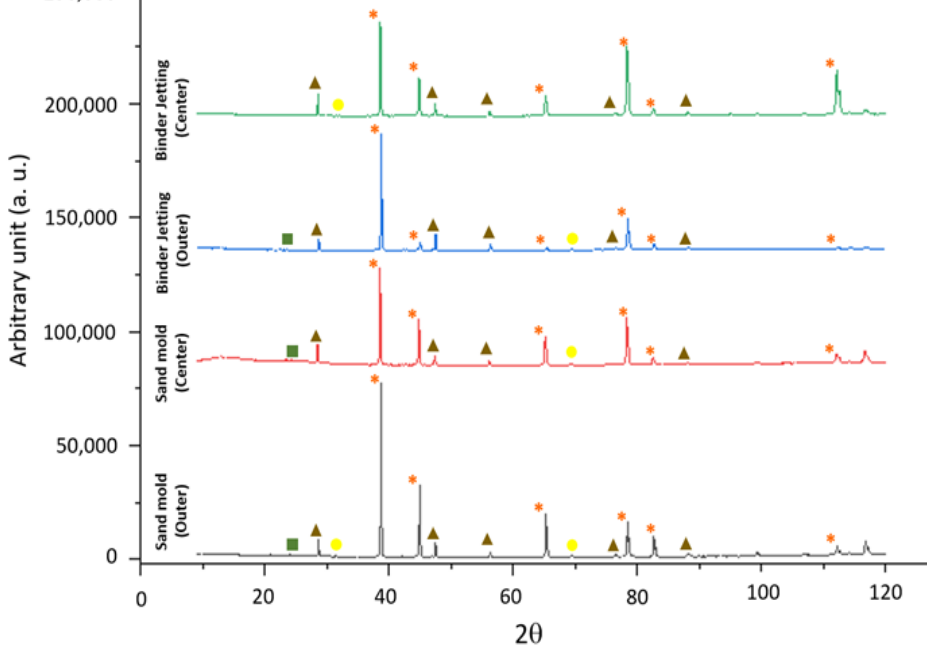
Figure 4. Mapping analysis of two different phases of iron. Chinese script ( a ), and irregular shape